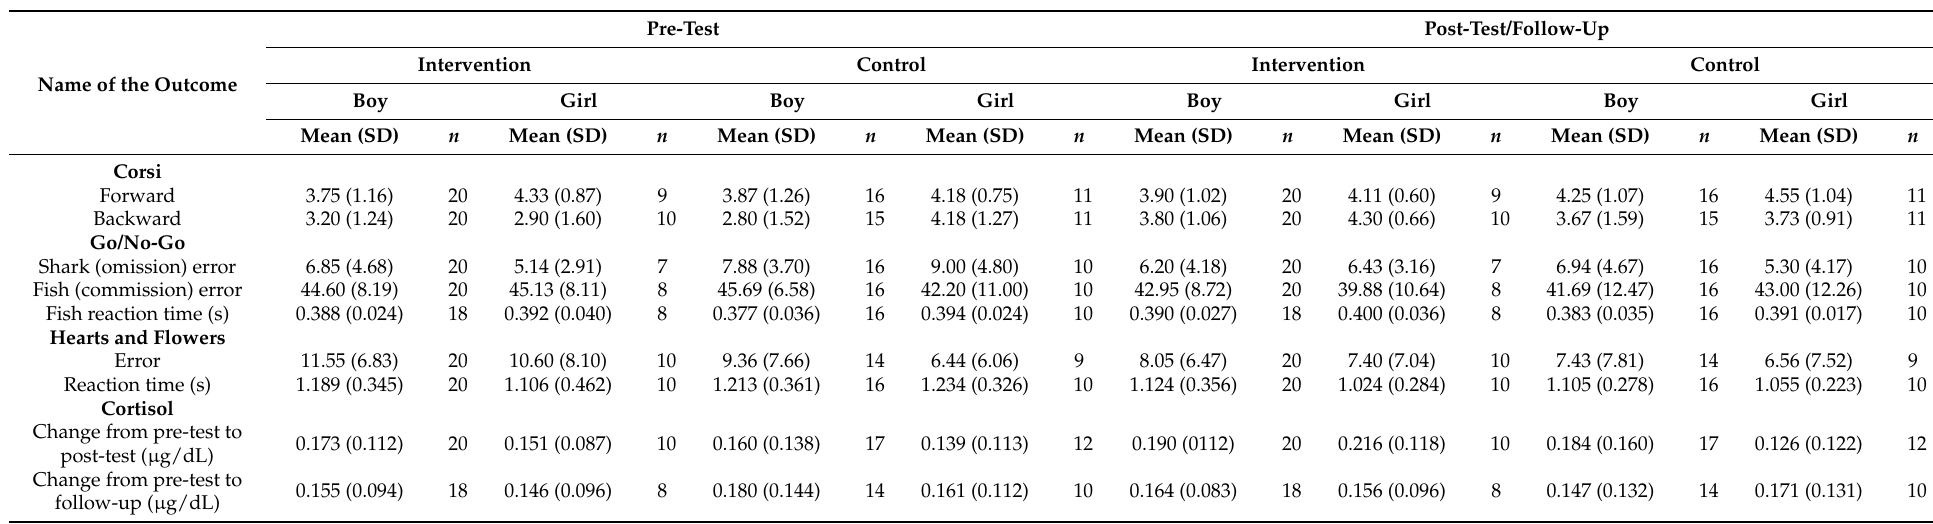
Table 1. Performance on cognitive tests and cortisol levels before and after the intervention (descriptive statistics).